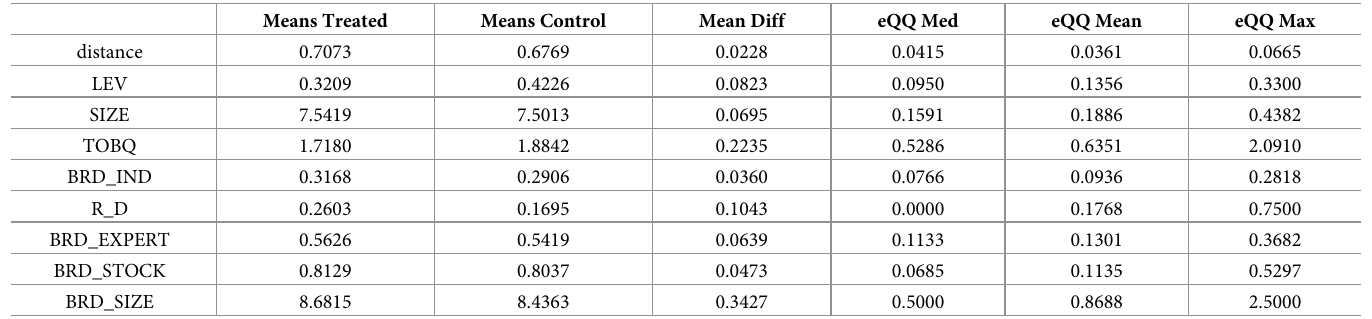
Table 8. Summary of balance across subclasses.